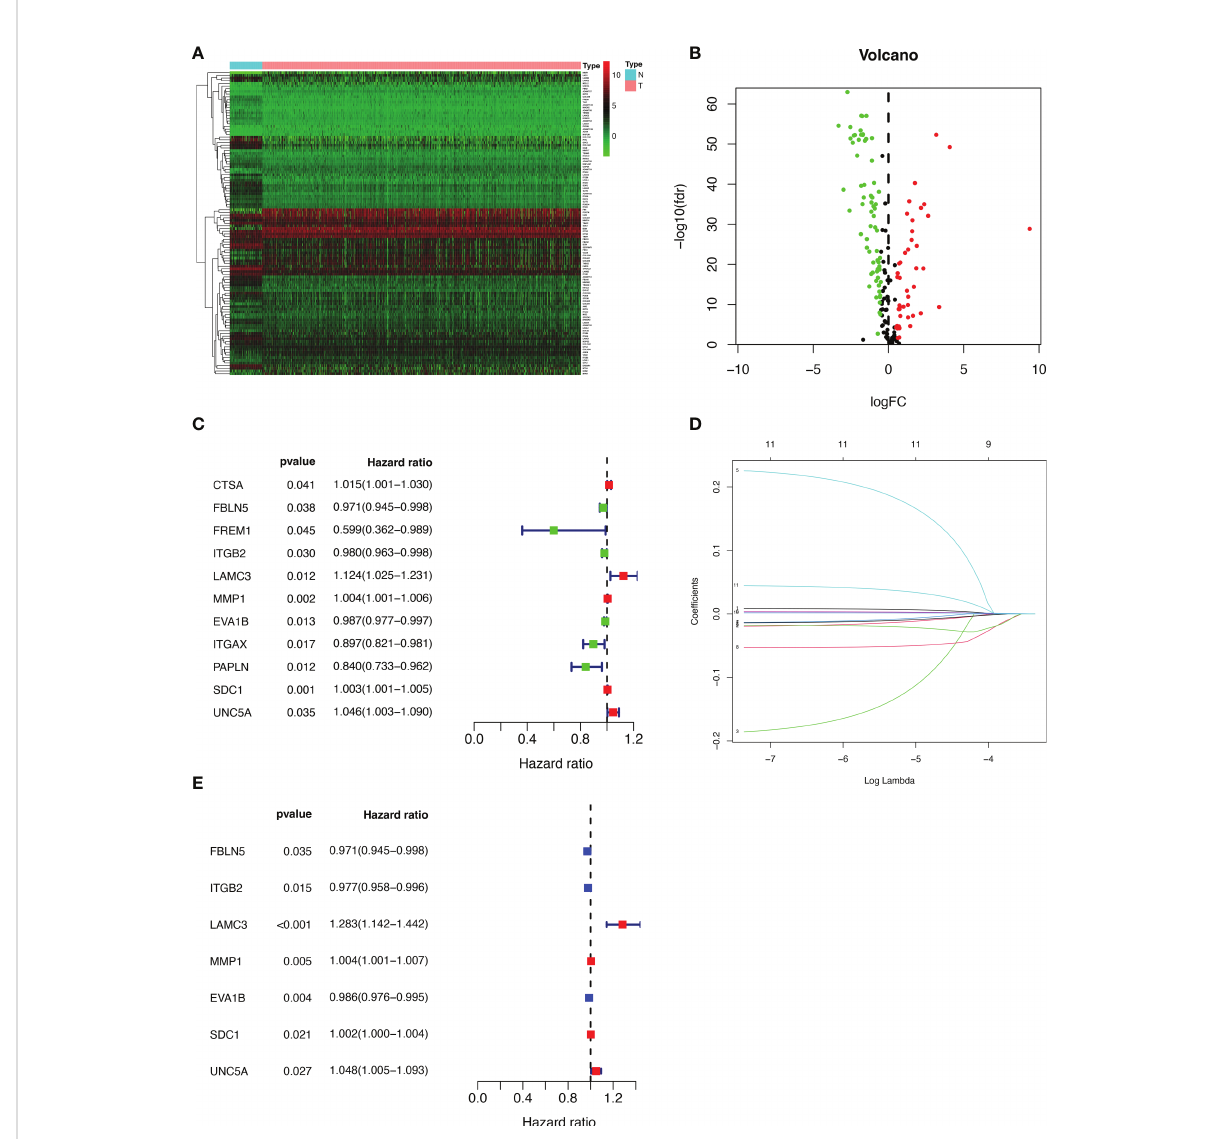
FIGURE 1 Extraction of differentially expressed BMRGs. (A) Heatmap of 113 differentially expressed BMRGs. (B) Volcano plot of 113 BMRGs expressed in BC tissues. Red dots represent up-regulated genes in tumor tissue while green dots represent down-regulated genes. (C) Forest plot of prognostic BMRGs extracted by univariate Cox regression analysis. (D) LASSO regression analysis curve. (E) Forest plot of prognostic BMRGs extracted by multivariate Cox regression analysis. BMRGs, basement membrane-related